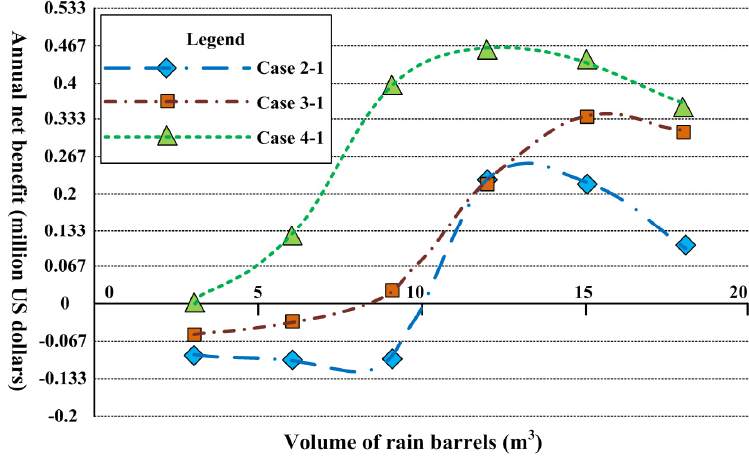
Figure 8. Comparative diagram of annual net benefit of each regularly designed